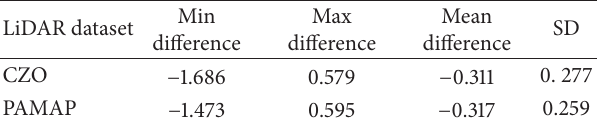
Table 2: Difference between surveyed points and the CZO and PAMAP LiDAR datasets (in